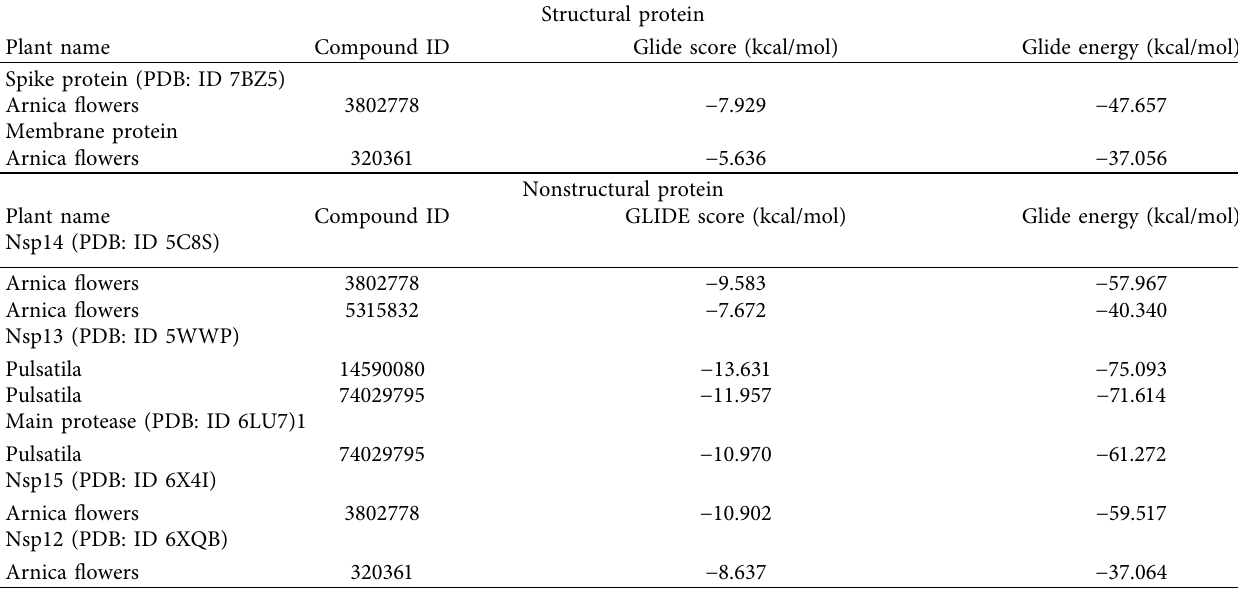
Table 1: Glide score and glide energy of homeopathy compounds with SARS-CoV-2 structural and nonstructural